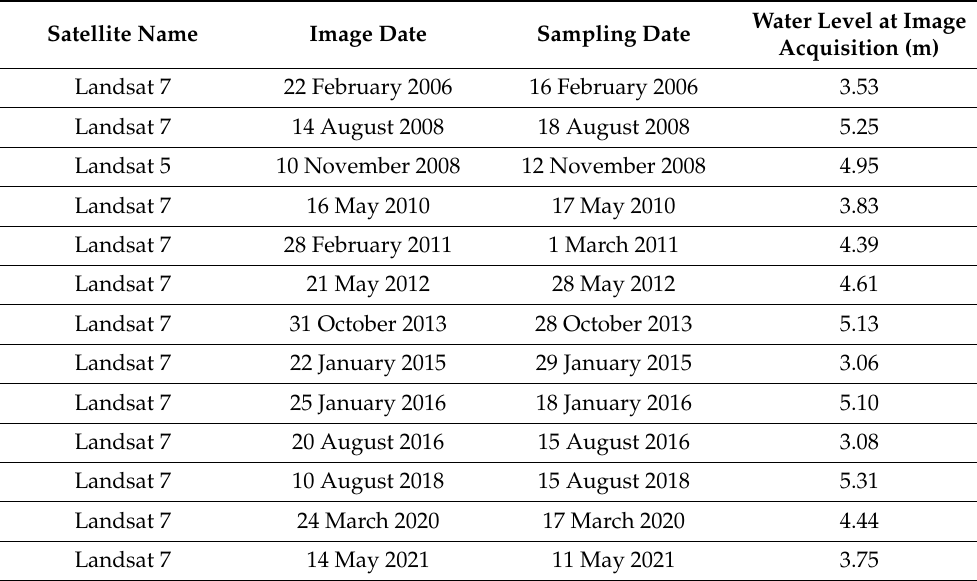
Table 3. Summary of Landsat images used in the calibration of the regression model (zero water level = 3.36 m below the mean sea level).